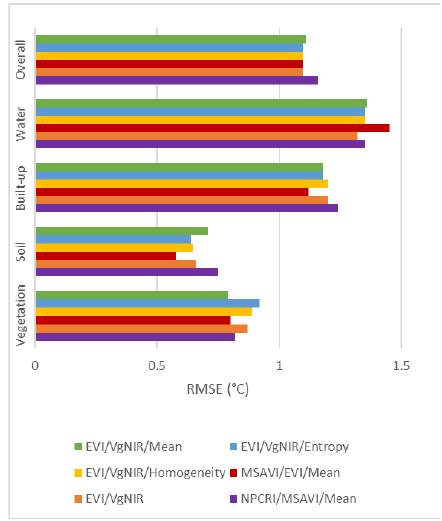
Figure 5. RMSE of each downscaled LST model per land cover